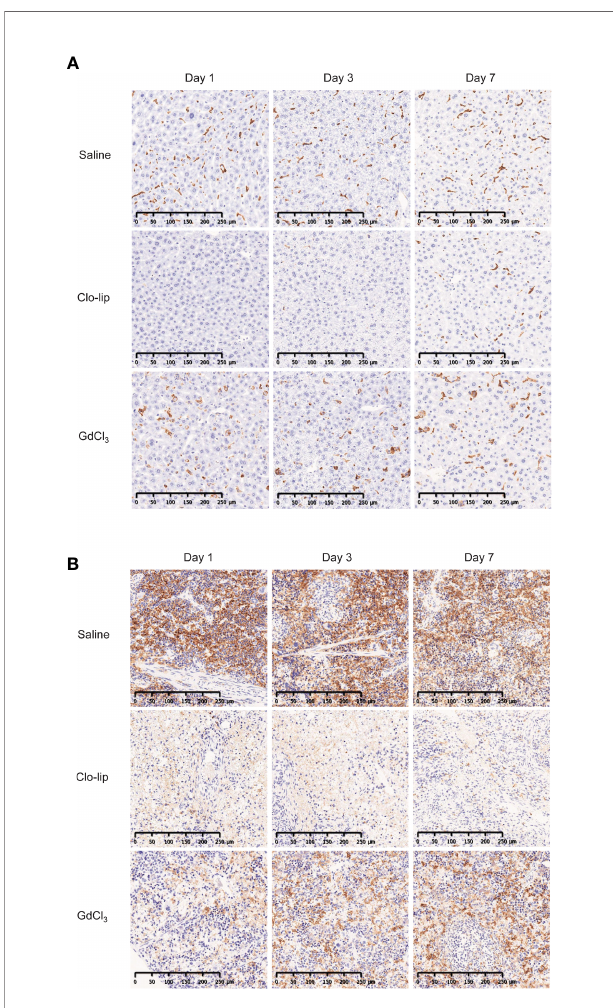
FIGURE 4 | Effects of Clo-lip and GdCl 3 on macrophages in NOG mice. NOG mice were administered saline, Clo-lip, or GdCl 3 four times at 3 – 4-day intervals. Livers (A) and spleens (B) were excised at 1, 3, or 7 days after the last treatment. Tissue macrophages were detected with anti-F4/80 antibody and visualized using diaminobenzidine (brown). Representative images are